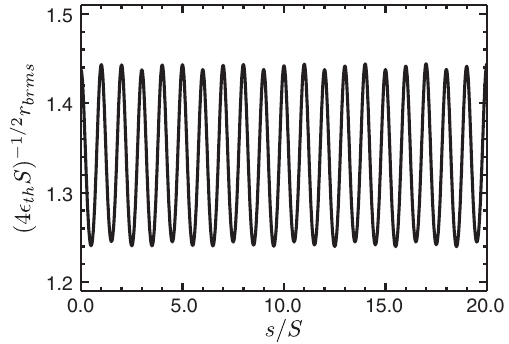
FIG. 1. Plot of the normalized rms beam radius S Þ (cid:1) 1 = 2 r ð 4 " th brms versus the normalized distance